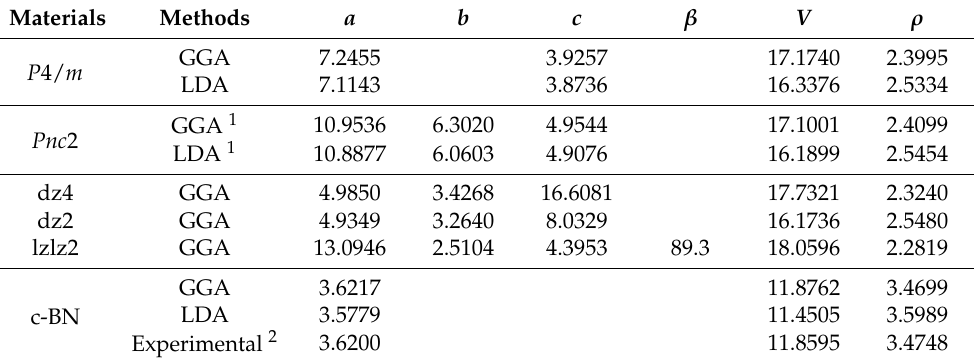
Table 1. Lattice constants (Å) and volumes per BN unit (Å 3 ) in the P 4/ m , Pnc 2, dz4, dz2 and lzlz2 phases and c-BN.